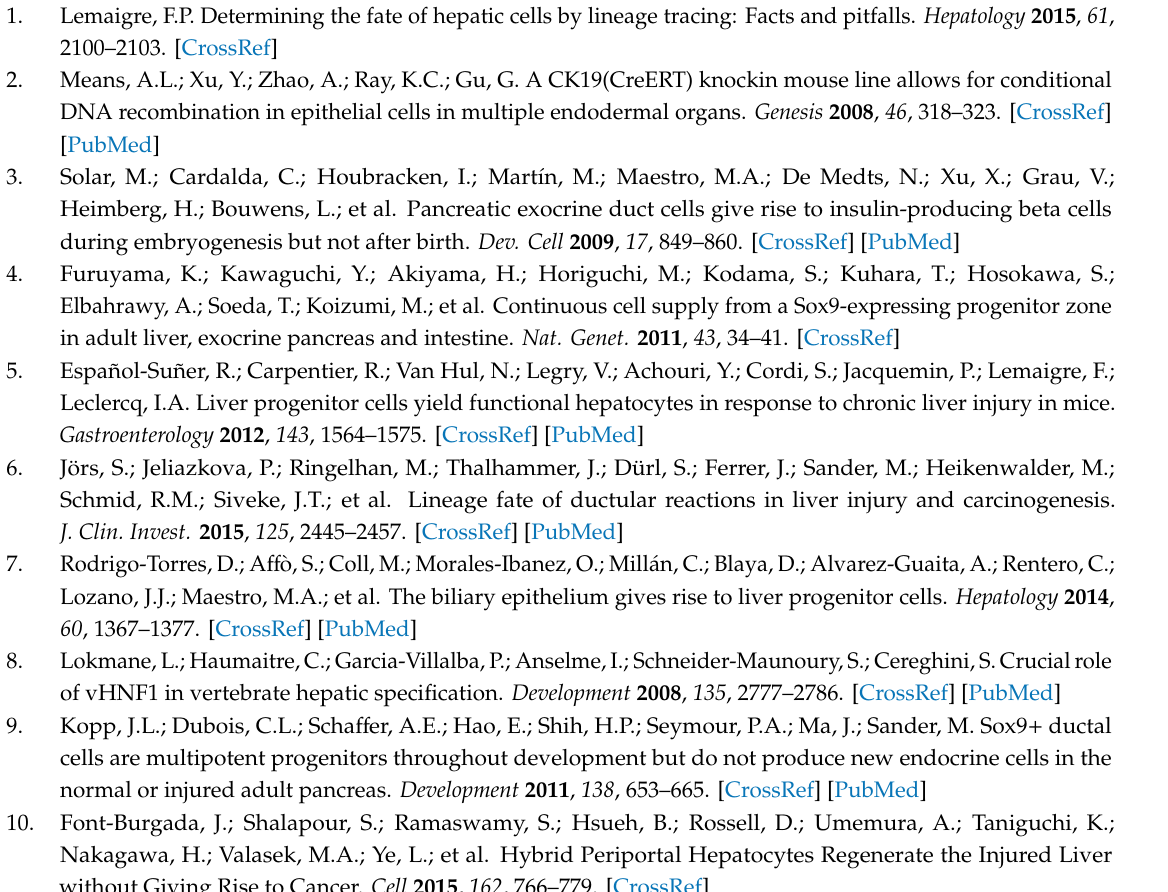
Figure S1: Troma III Ck19 antibody labels all cholangiocytes, Figure S2: Ck19 expression is abrogated in homozygous Ck19-CreER-tdTomato mice, Figure S3: The Ck19-CreER T and Opn-iCreER T2 drivers do not trigger recombination in hepatic stellate cells or immune cells, Figure S4: CCl 4 injection causes necrosis of centrilobular hepatocytes, Figure S5: The Ck19-CreER T and Opn-iCreER T2 drivers do not trigger recombination in hepatic stellate cells or immune cells after liver